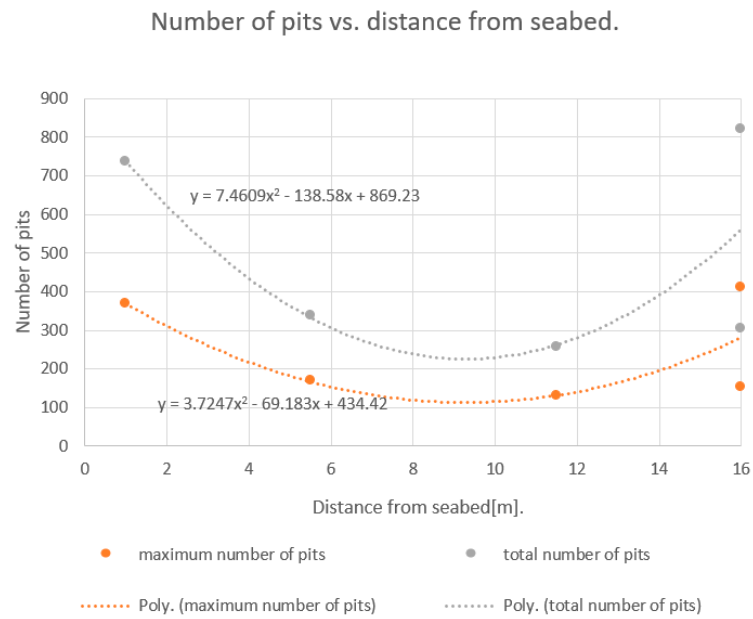
Figure 8. Number of pits to